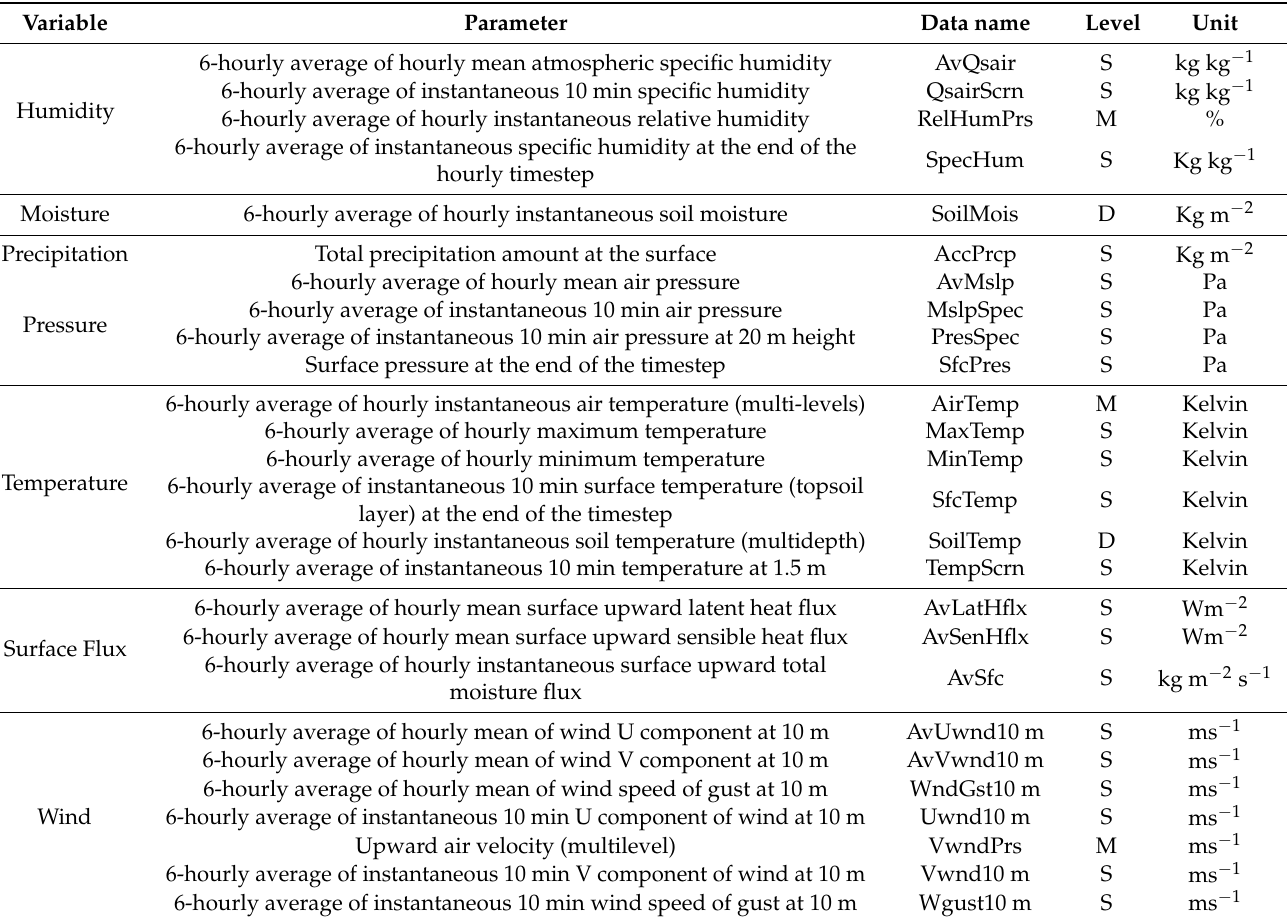
Table 1. List of meteorological variables and parameters included in the analysis. The level column represents the number of vertical levels data collected. Single-level (S) data are measured at 1.5 m (unless specified otherwise). Multilevel data (M) represent 11 vertical levels determined by pressure isobars (1000 hPa, 975 hPa, 950 hPa, 925 hPa, 900 hPa, 850 hPa, 800 hPa, 750 hPA, 700 hPa, 600 hPa, 500 hPa) and multidepth data (D) include measurements from 4 different depth levels (0.05 m, 0.225 m, 0.675 m, and 2